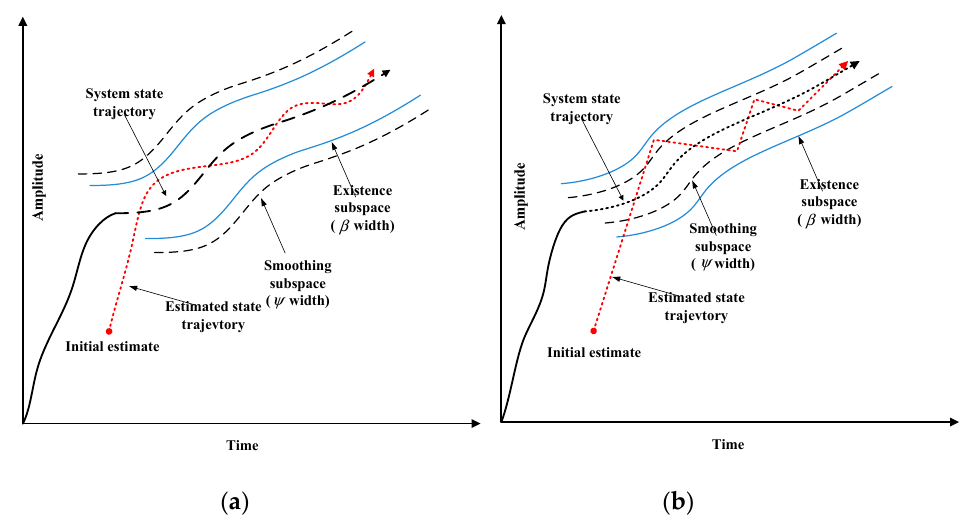
Figure 2. Smoothing boundary layer concept [10,32] ( a ) Smoothed estimated trajectory ( ψ ≥ β ) ; ( b ) Presence of chattering e ff ect ( ψ ≤ β ) .